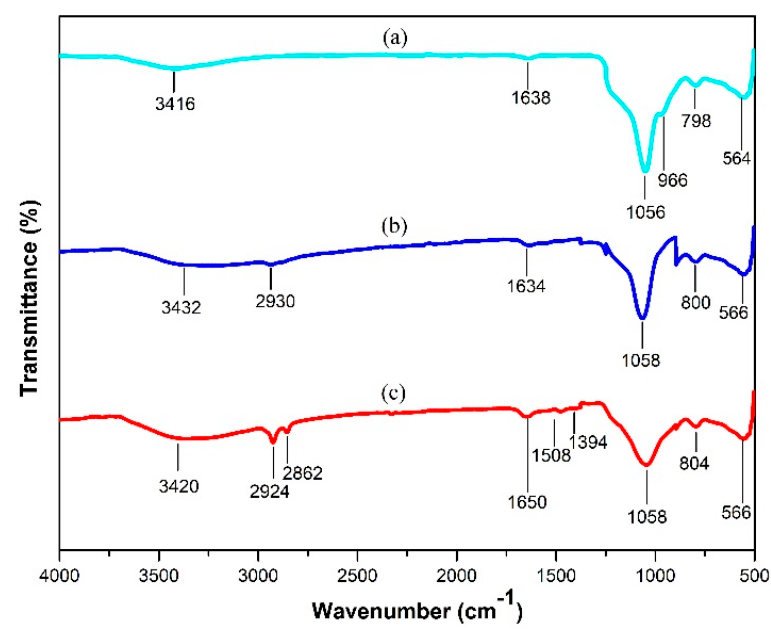
Figure 3. FTIR spectra of ( a ) SiO 2 /Fe 3 O 4 /GO, ( b ) GL-A-SiO 2 /Fe 3 O 4 /GO, and ( c ) CRL/SiO 2 /Fe 3 O 4 /GO.